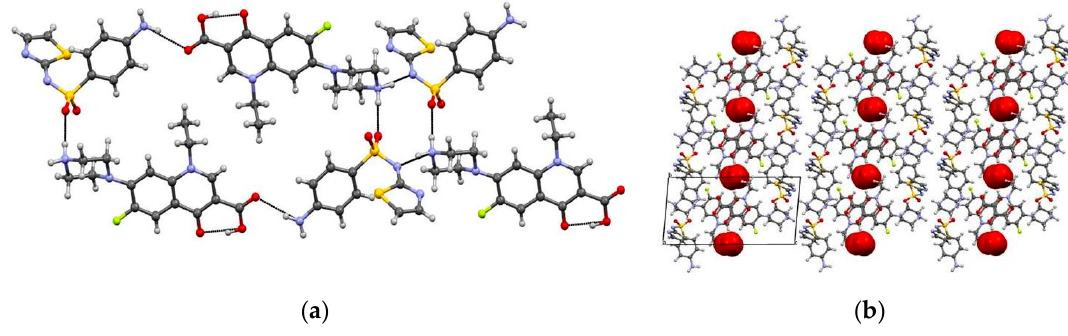
Figure 34. ( a ) Hydrogen bond interaction present in NF-ST salt hydrate; ( b ) packing diagram showing water channel present in the salt hydrate. Adapted with permission from Molecular Pharmaceutics ,